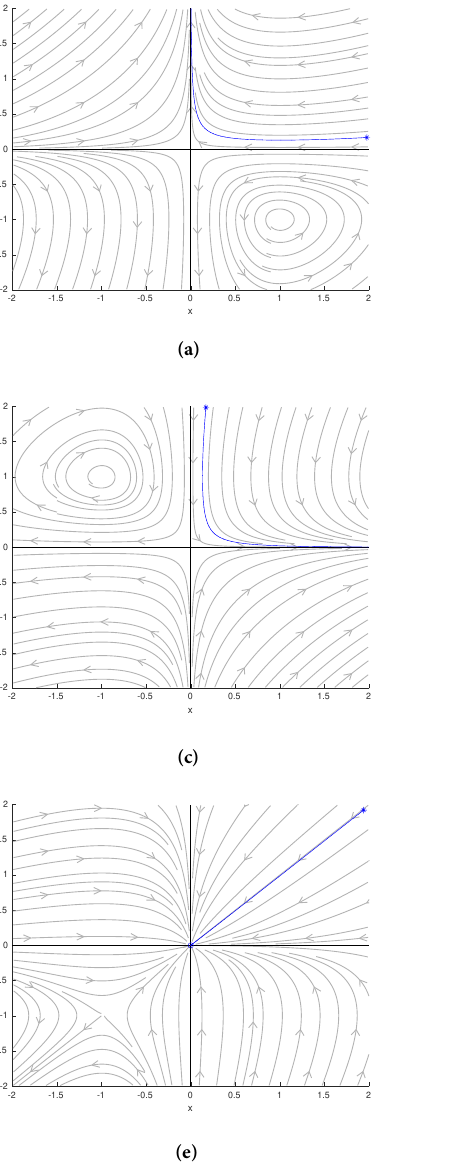
Figure 3. Simulations for cases 2, 3 and 4. This figure corresponds to another case of entrance rates growth being higher than exit rates in both automobile categories. In ( a , b ), the scrapping of conventional automobiles is greater than the entry into the fleet (sales), while in ( c , d ), sales of conventional automobiles are greater than their operating output (scrap), which increases the number of automobiles in the fleet. Finally, in ( e , f ), the lack of interest in the two technologies can be seen, causing their disappearance.